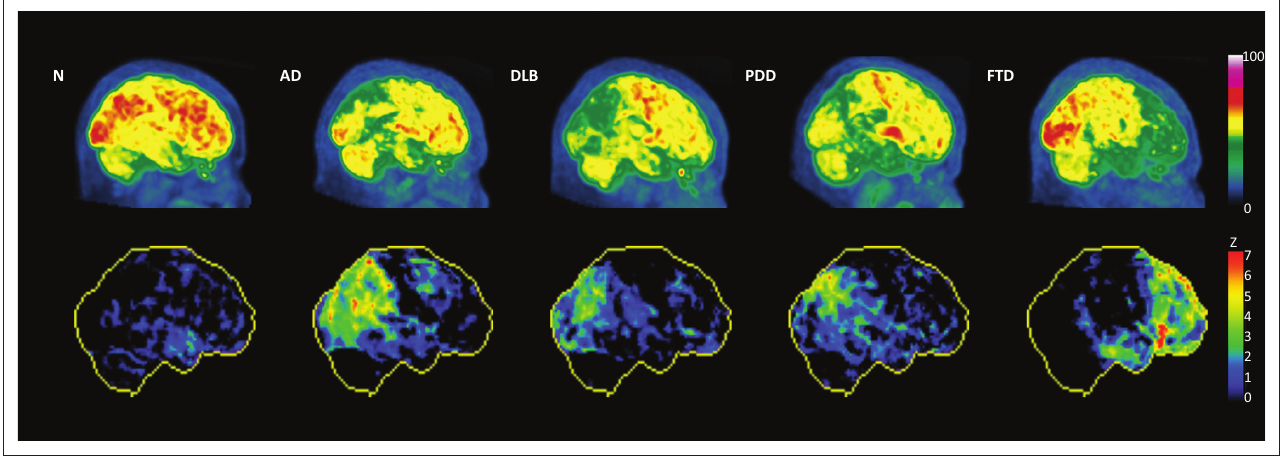
N, Normal, AD, Alzheimer’s dementia, DLB, dementia with Lewy Bodies, PDD, Parkinson’s disease with dementia, FTD, frontotemporal dementia. FIGURE 1: Fluorine-18 FDG PET scans in dementia. Maximum intensity projections of the PET scan (in the right lateral position) are shown on the top row (individually scaled for comparability). Corresponding statistical images (reductions compared to a normal database) are shown in the bottom row.